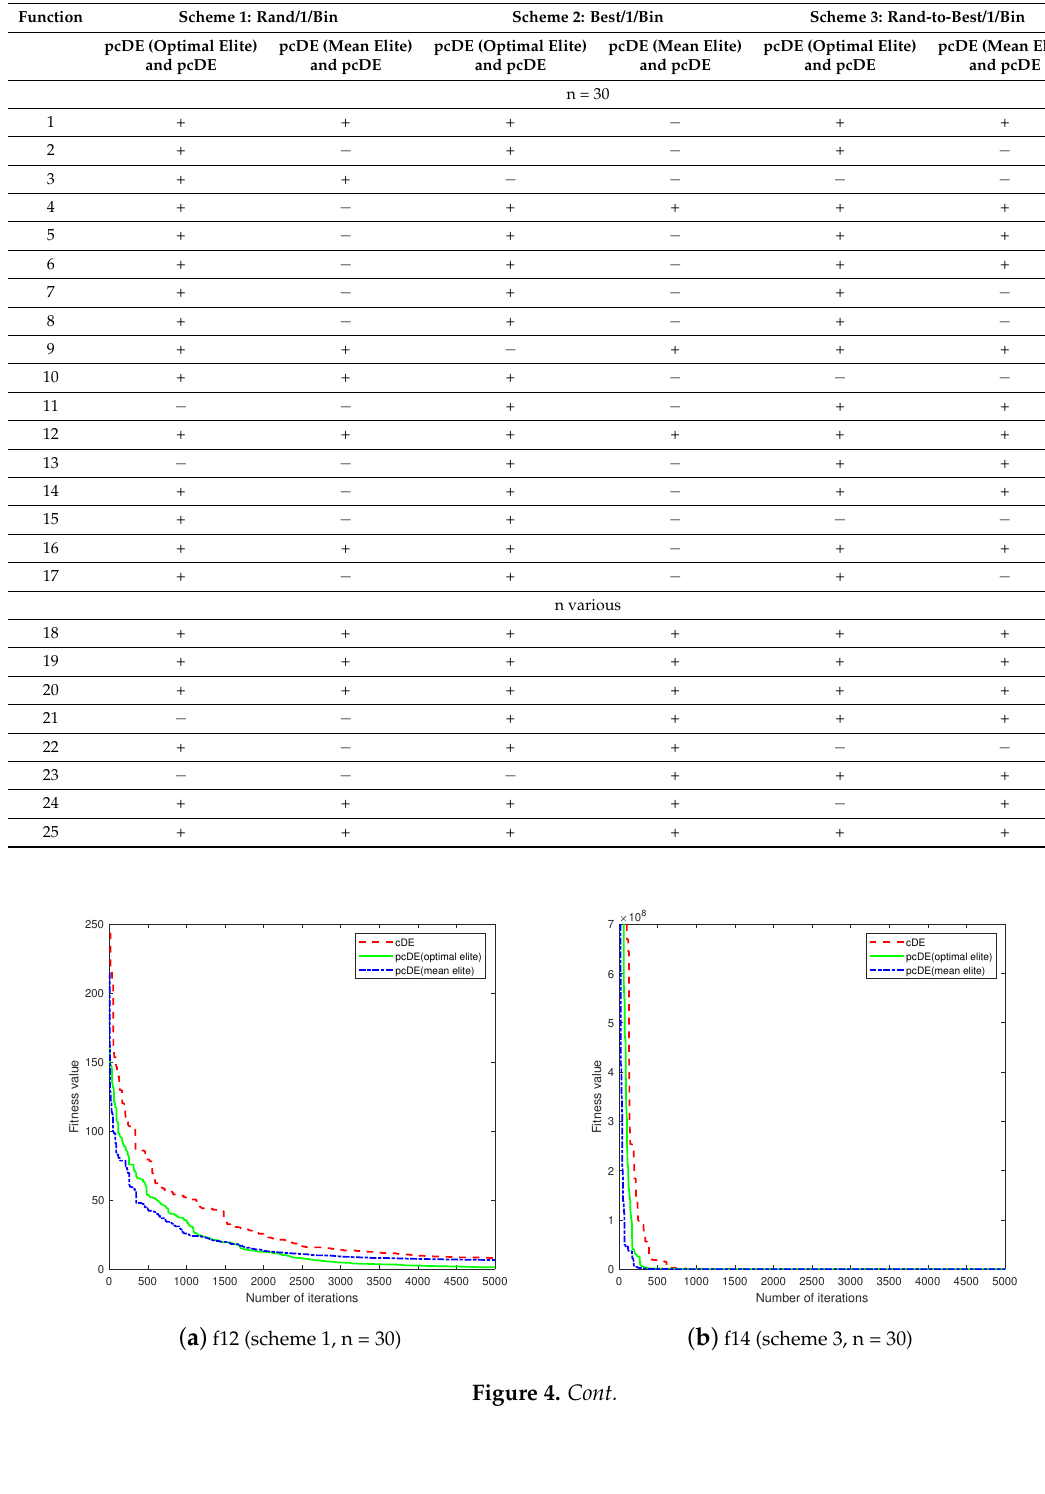
Table 3. Two communication strategies under three different schemes. Function Scheme 1: Rand/1/Bin Scheme 2: Best/1/Bin Scheme 3: Rand-to-Best/1/Bin